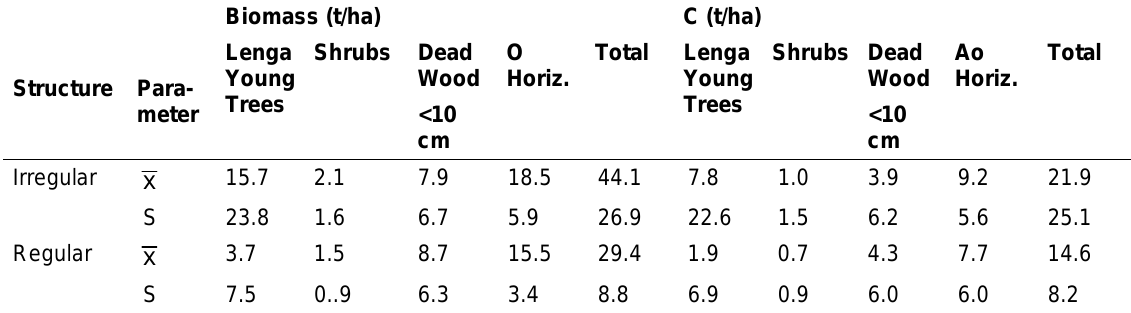
Biomass and C Content in O Horizon, Herbage, and Young